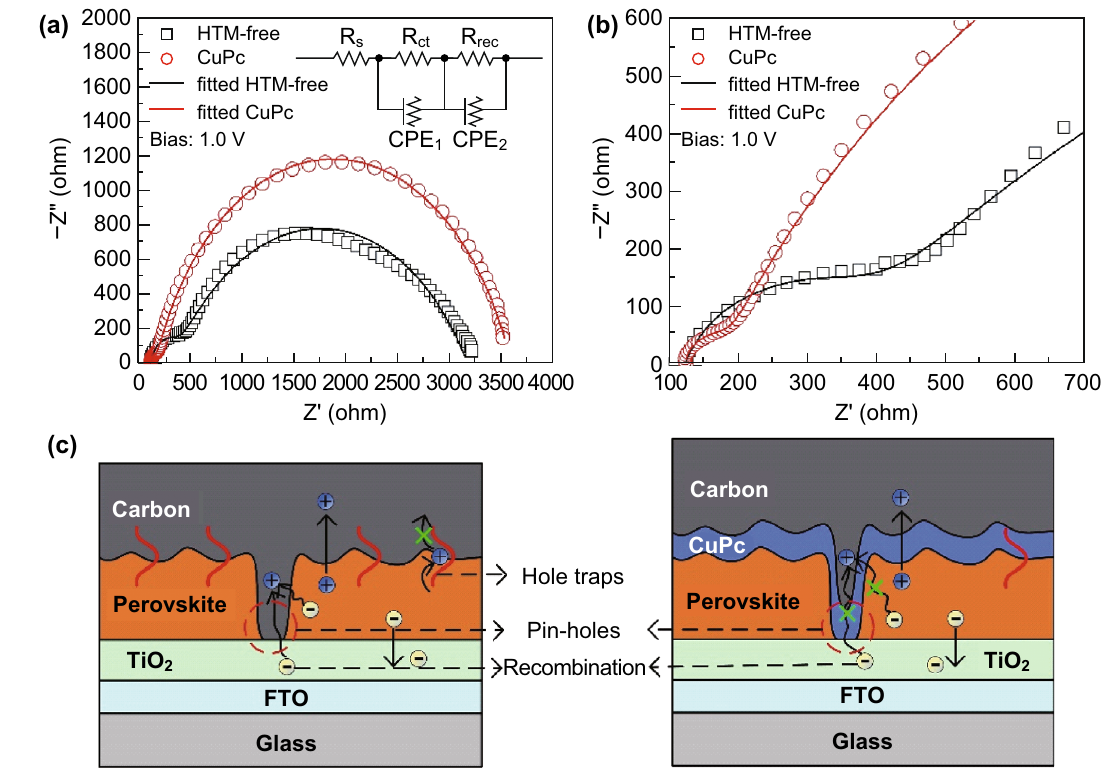
Fig. 5 a Nyquist plots at bias 1.0 V of the HTM-free and CuPc-based CsPbBr 3 PSCs in the dark. Inset: the equivalent circuit employed to fit the Nyquist plots. b Nyquist plots in the high frequency range. c Illustration depicting the function of CuPc as HTM layer in